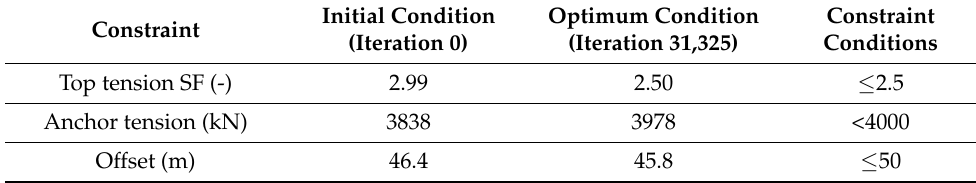
Table 9. Constraint results for case B.